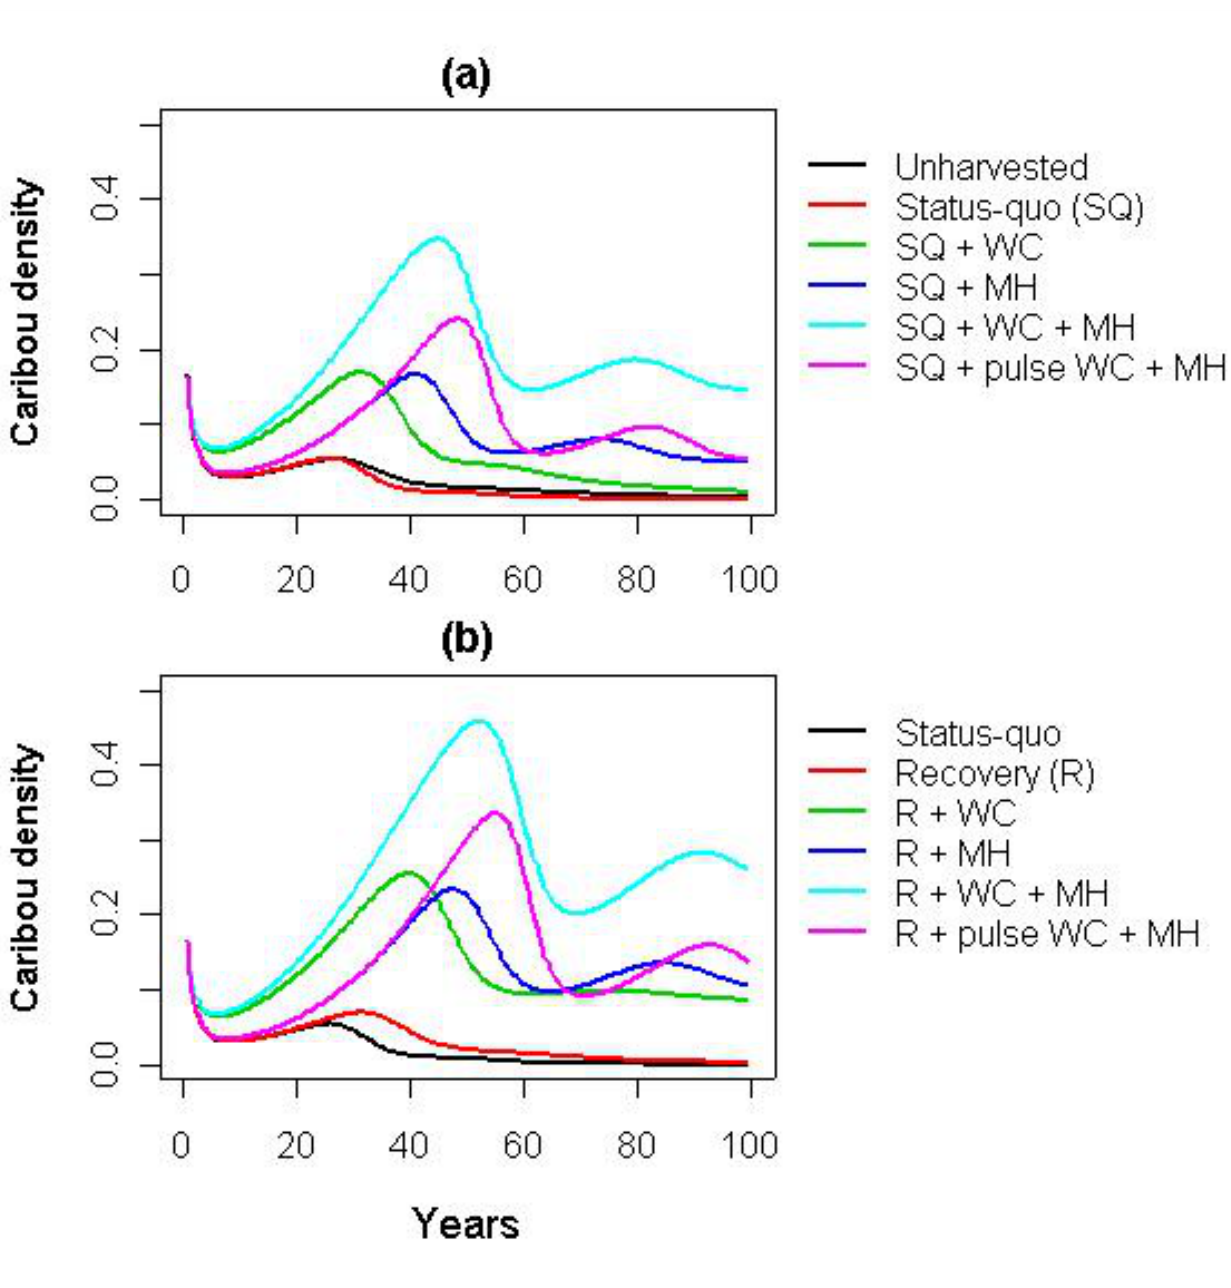
Fig. 4. Predicted caribou densities (animals km 2 ) under alternative management options. WC = Wolf control; MH = Moose harvest; Pulse WC = 10-year timed wolf